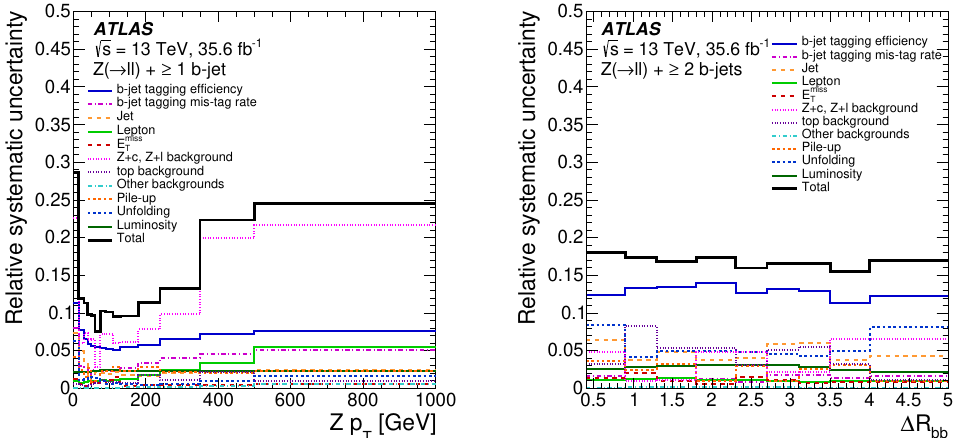
Figure 6 . Relative systematic uncertainties in the (cid:12)ducial cross-section as a function of the Z - boson p T in events with at least one b -jet (left) and as a function of the (cid:1) R between the two leading b -jets in events with at least two b -jets (right). The total uncertainty is shown in black while the di(cid:11)erent components listed in table 8 are shown in di(cid:11)erent